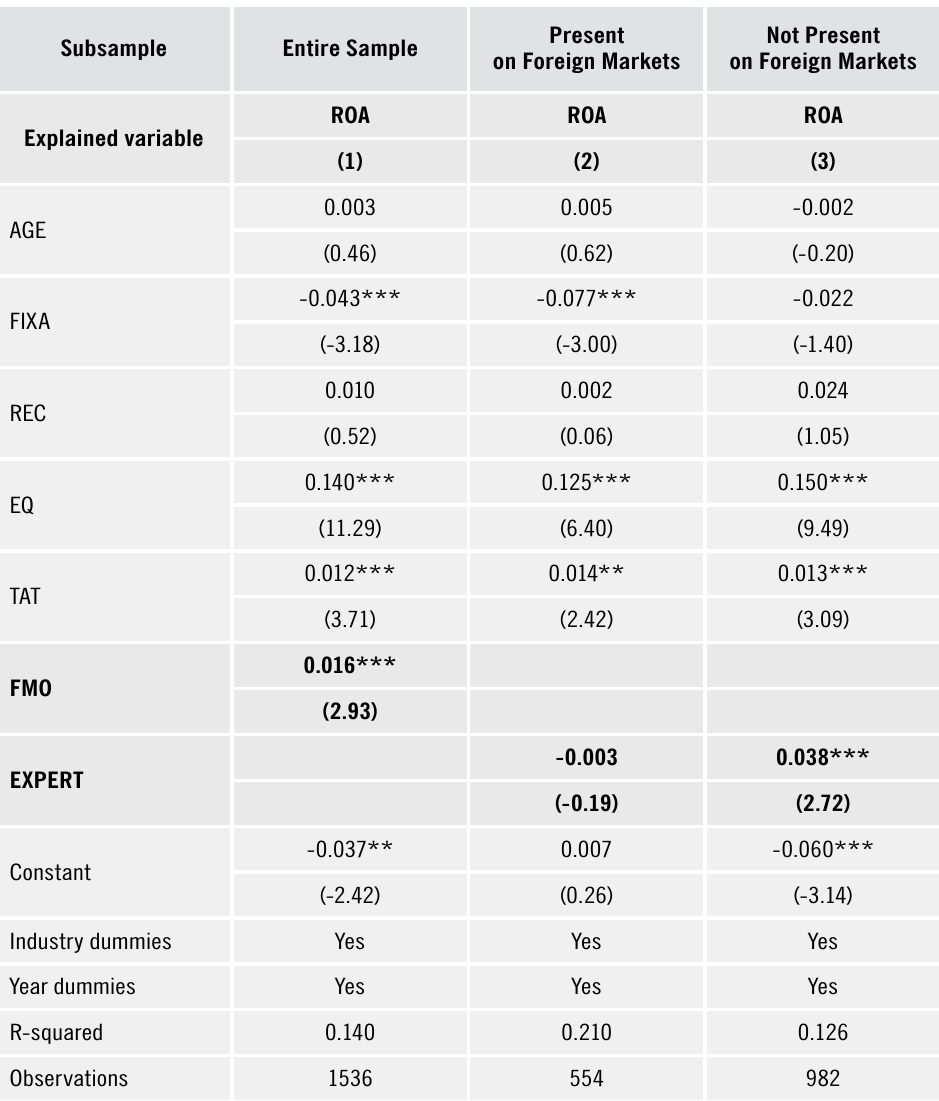
Table 7. Empirical relationship between international expert share and firm contemporaneous